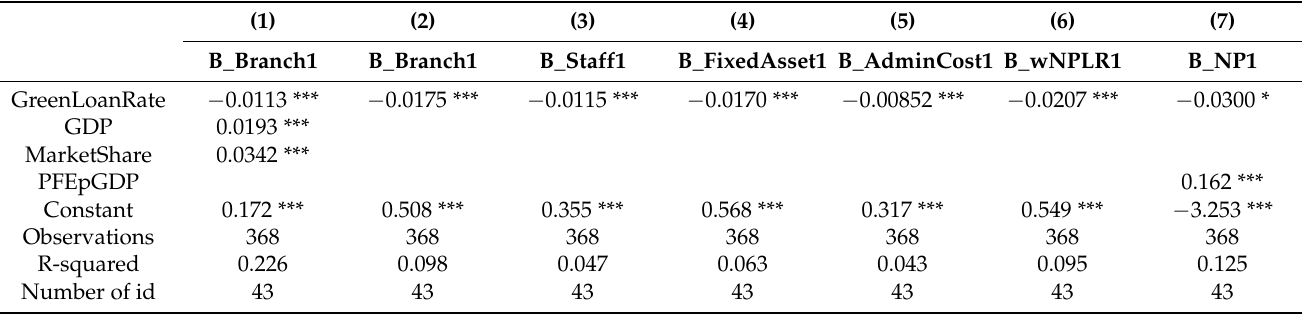
Table 9. Regression results for the robustness test (objective function